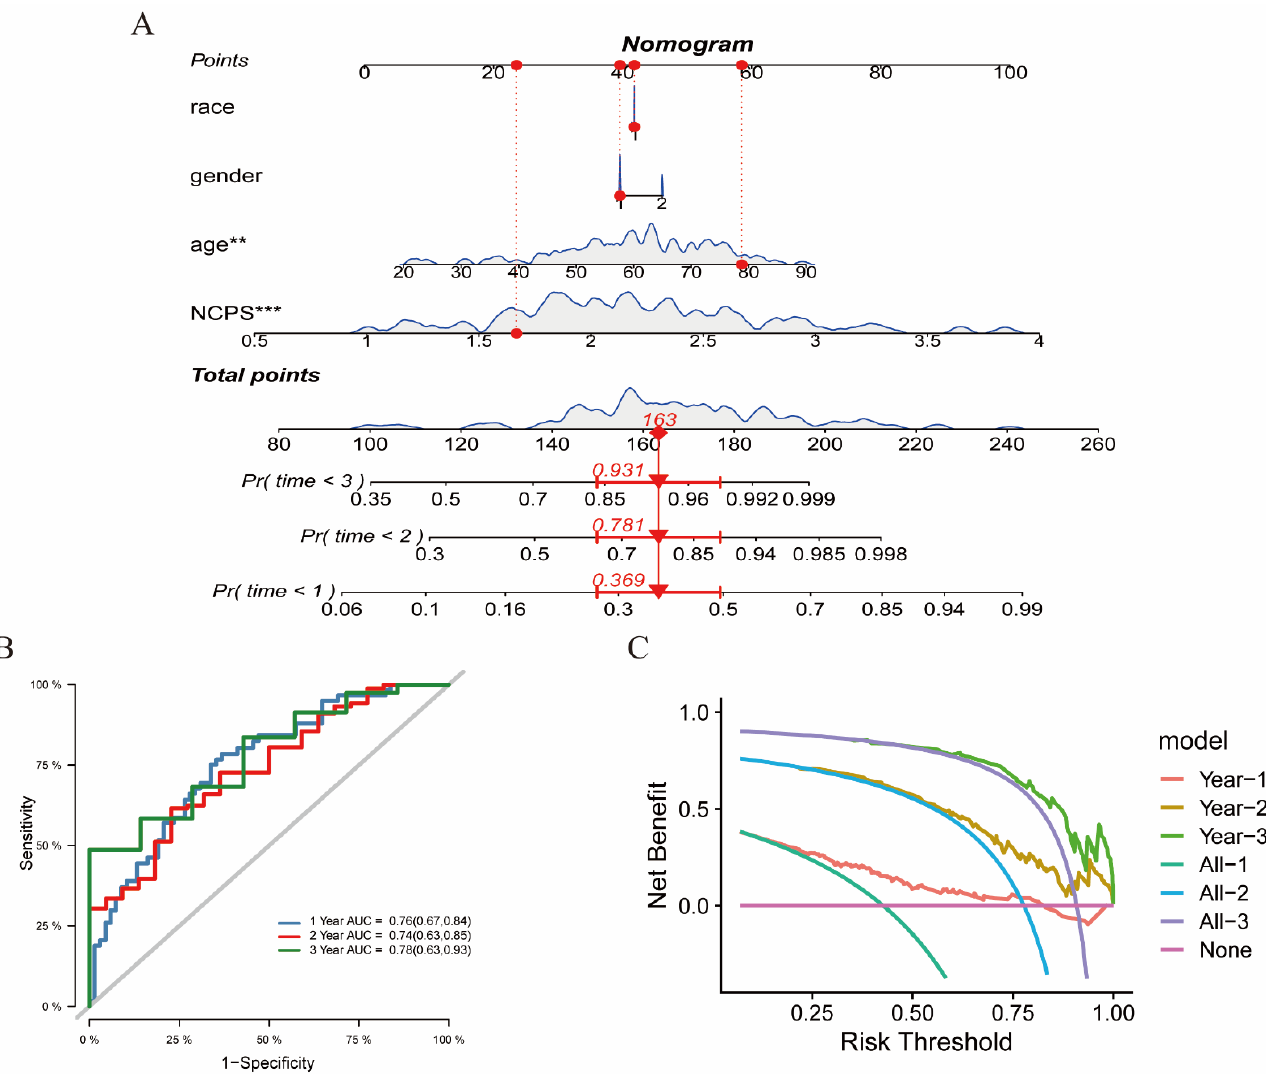
Figure 7. The construction of a nomogram. ( A ) Nomogram of patient “TCGA-02-0047”. The mortality rates at 1, 2, and 3 years were estimated from the “TCGA-02-0047” patients by gender, age, race, and NCPS scores of 0.369, 0.781, and 0.931, respectively. ( B ) ROC curve of the nomogram. The area under the curve (AUC) in 1, 2, and 3 years were 0.76, 0.74, and 0.78, respectively. ( C ) Decision curve analysis. This method is effective in predicting the prognostic survival time of patients. ** p < 0.01; *** p < 0.001.